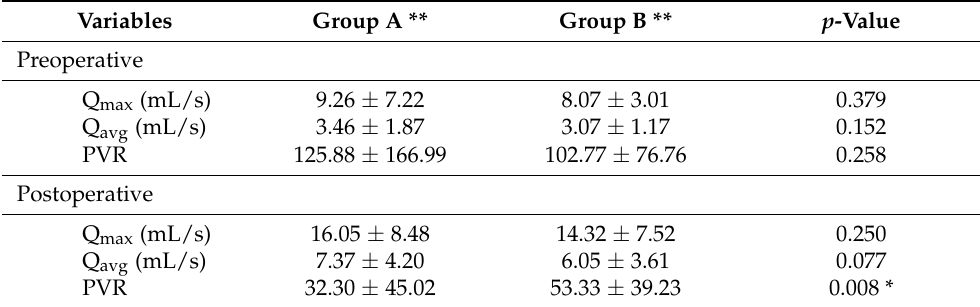
Table 3. Uroflowmetry between different prostate volume.